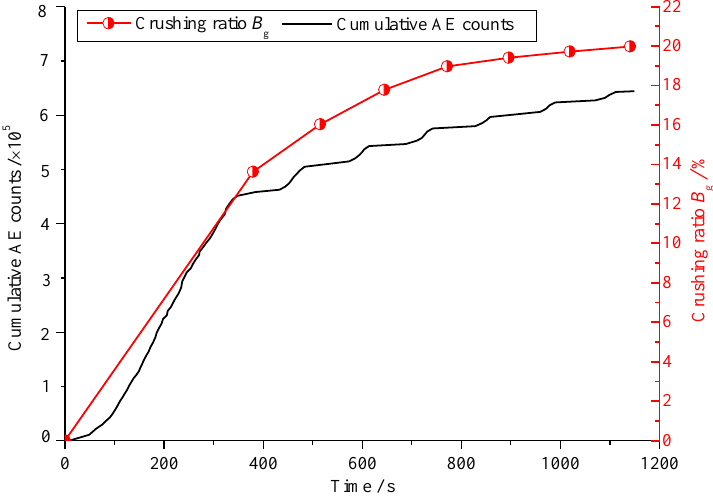
Figure 10. The evolution characteristics of cumulative AE counts under the CACL experiment.